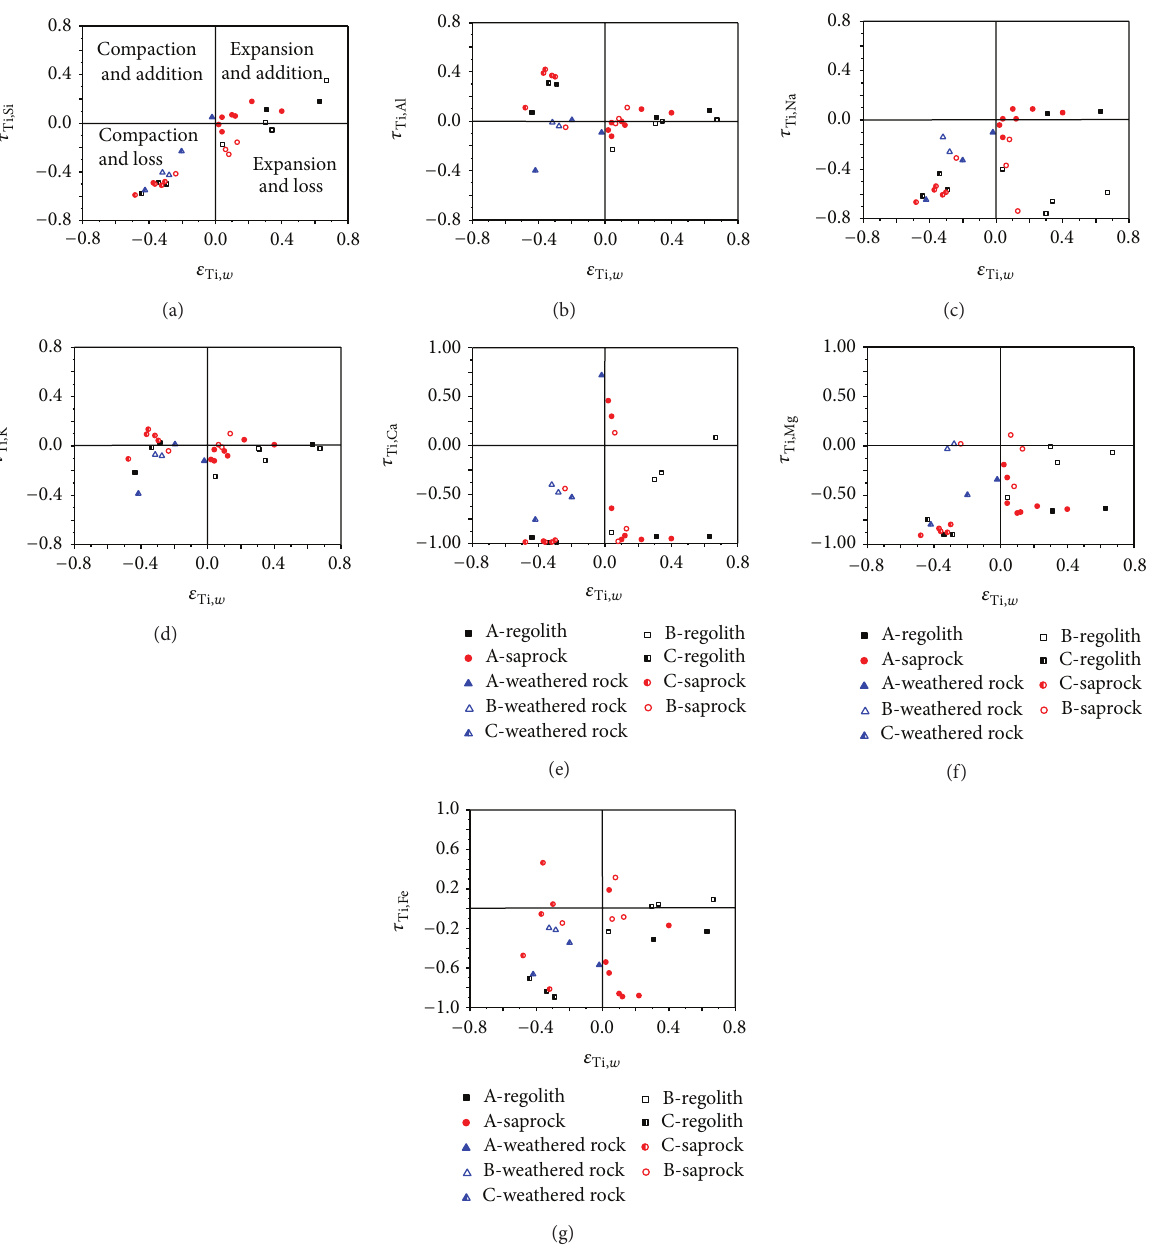
Figure 5: Mass transfer coefficient 𝜏 of (a) Si, (b) Al, (c) Na, (d) K, (e) Ca, (f) Mg, and (g) Fe versus strain calculated using Ti. minerals dominates chemical gains and losses. The calculated maximum mass fluxes of Al are 47, − 65, and 207 mol m −2 in the regolith zones of profiles A, B, and C, respectively, as inte- grated over sampling depth. Furthermore, Al is